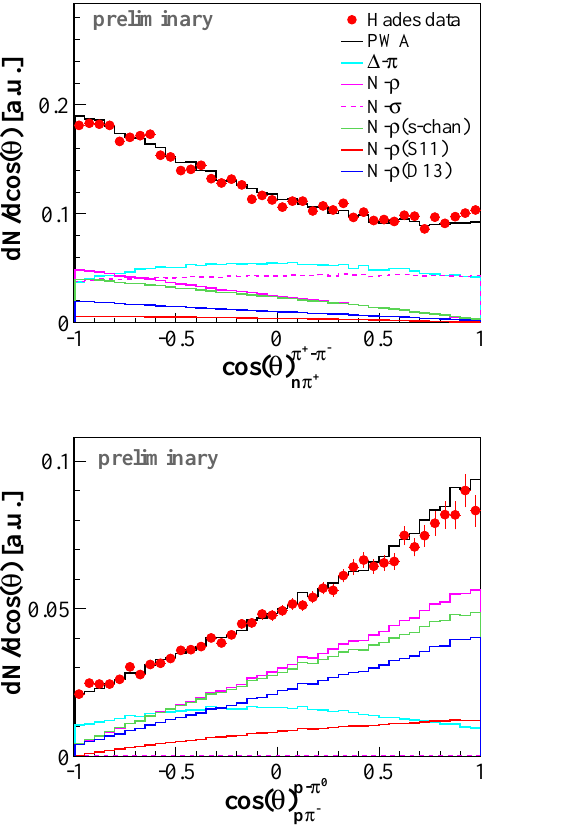
Figure 2. (Color online) Di ff erential distributions of pions in the nucleon-pion (left column) and nucleons in the pion-pion (right column) helicity frames for the π − p → n π + π − (upper row) and π − p → p π 0 π − (lower row) reaction channels obtained at 0.654 GeV / c pion beam momentum. Colour lines represent various final state contributions (indicated in the